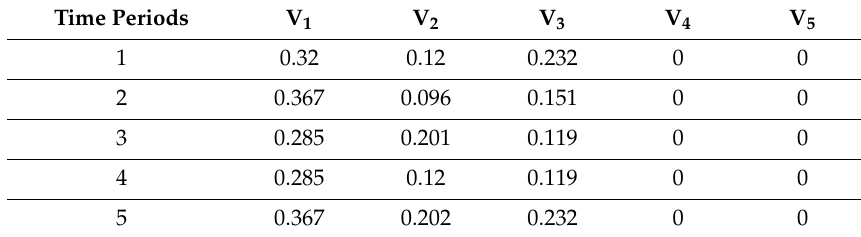
Table 10. The BPAs of monitoring point #1 at five time periods.